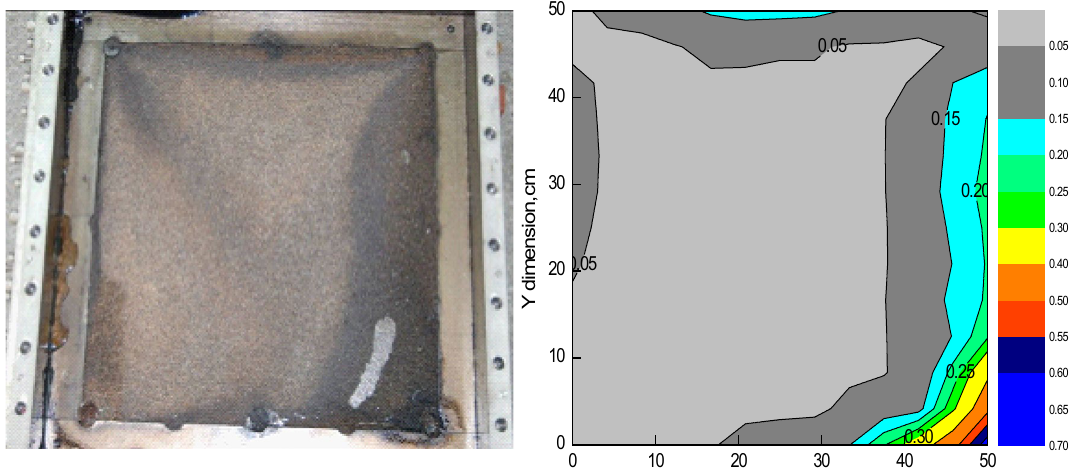
Fig. 5 Photograph of post ISC and the saturation